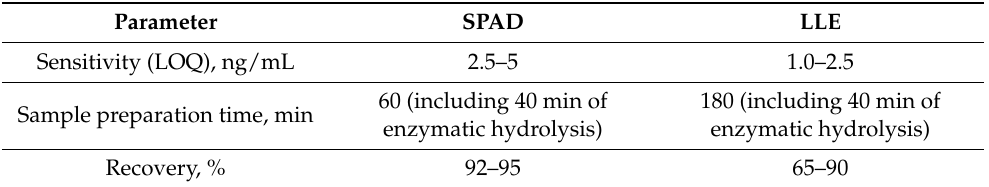
Table 5. Analytical performance of SPAD and LLE procedures combined with GC-MS/MS determi- nation of steroid hormones.